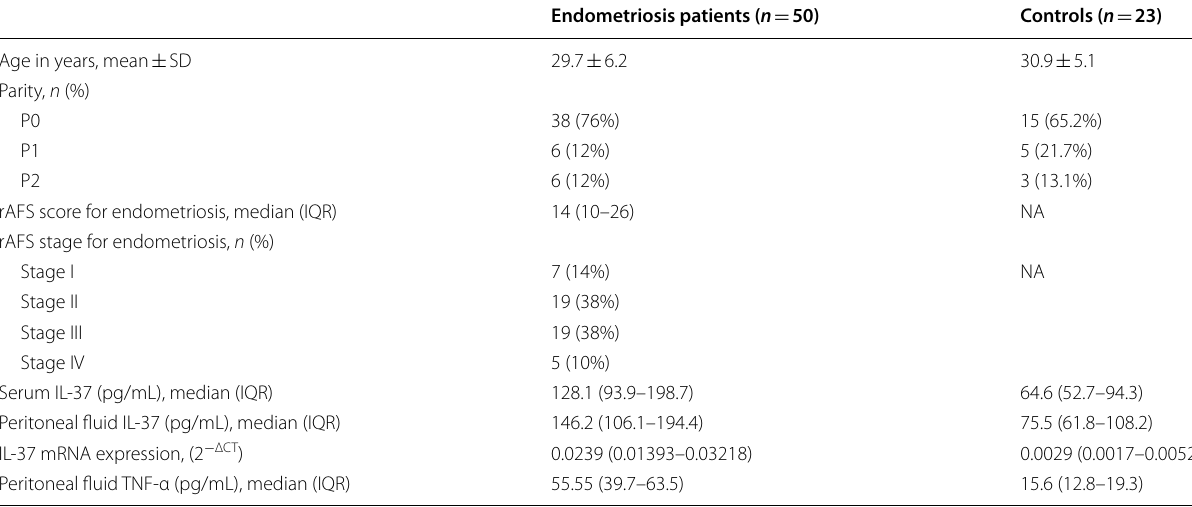
IQR interquartile range, NA not applicable, rAFS revised American Fertility